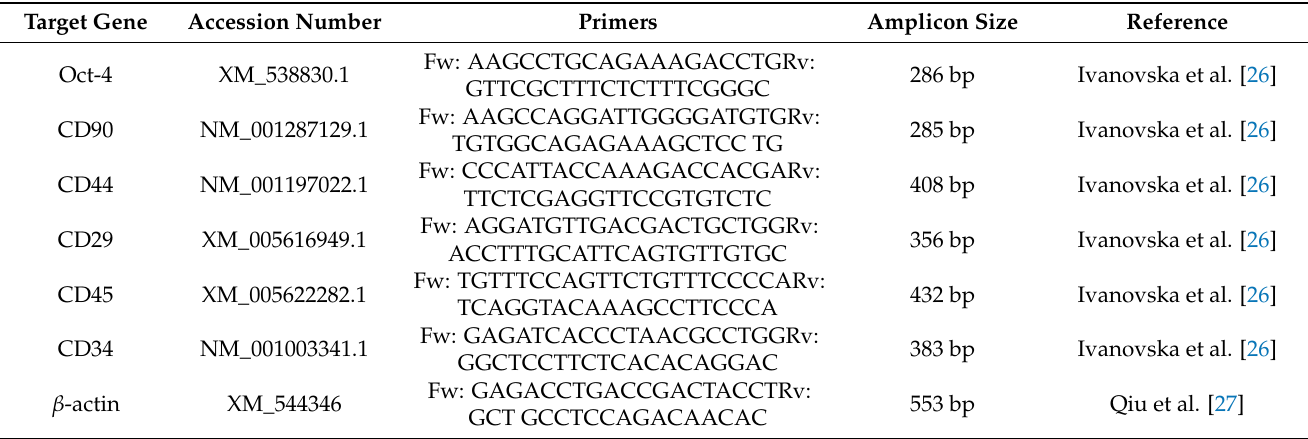
Table 2. Primers used in